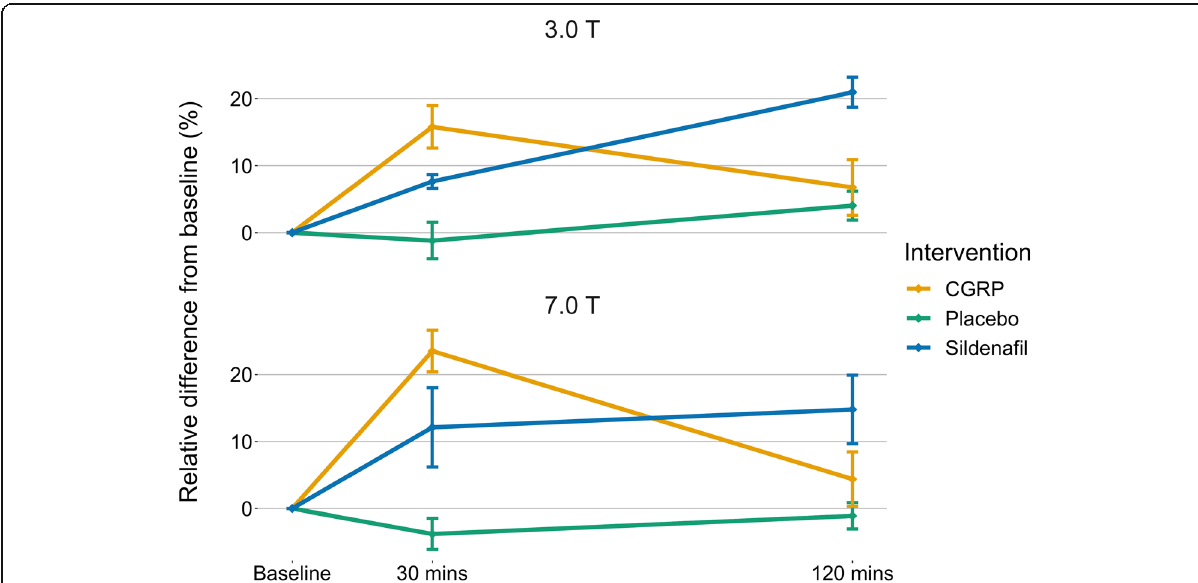
Fig. 2 Change in intradural MMA circumference over time after each of the three interventions. 3.0 T and 7.0 T data is depicted as mean ± SE, all data analyzed with LAVA software